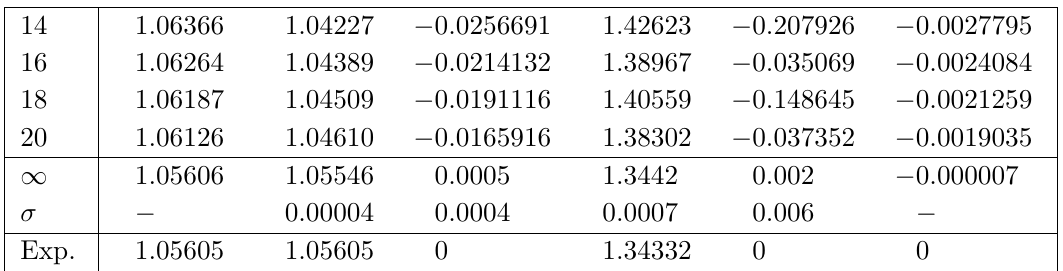
boundary 2 WZW model, while the k